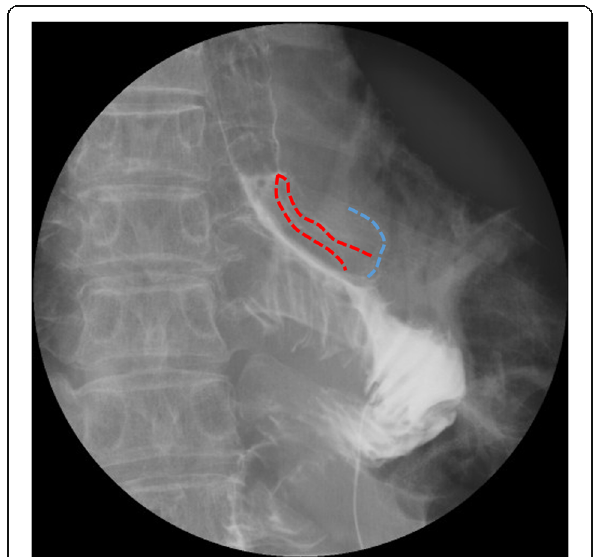
Fig. 2 X-ray image with contrast medium on postoperative day 2 revealing no leakage of the esophagojejunostomy. Esophageal stump (dashed blue line) and stapled lines of the entry hall (dashed red line) can be seen